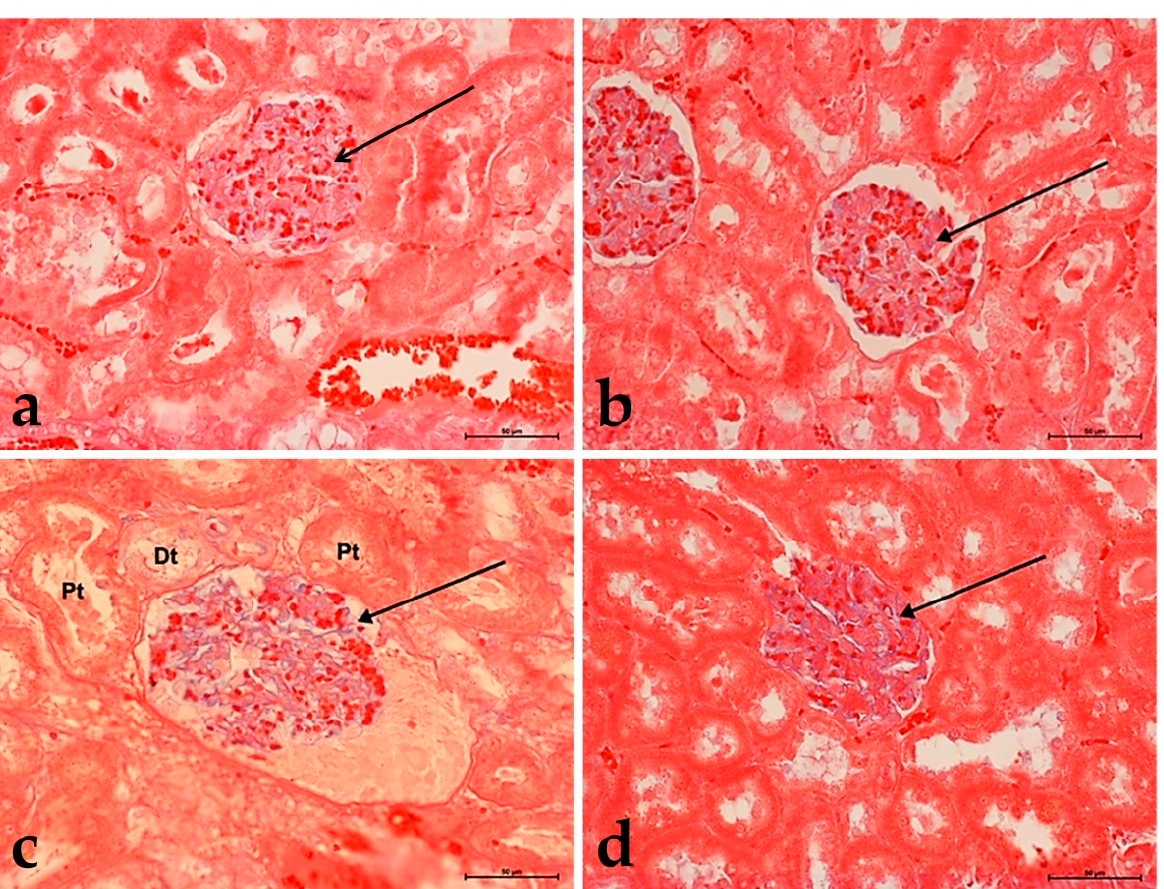
Figure 5. The changes in the structure of the kidneys in animals fed with a normal diet—groups II ( a ), III ( c ), and in animals fed with high-cholesterol diet—groups IIa ( b ), IIIa ( d ). A glomerulus with different proteoglycan content (arrow). Note the presence of urine in the glomerulus in group III ( c ). Alcian blue staining. Mag. 200×. Bar scale 50 µm.